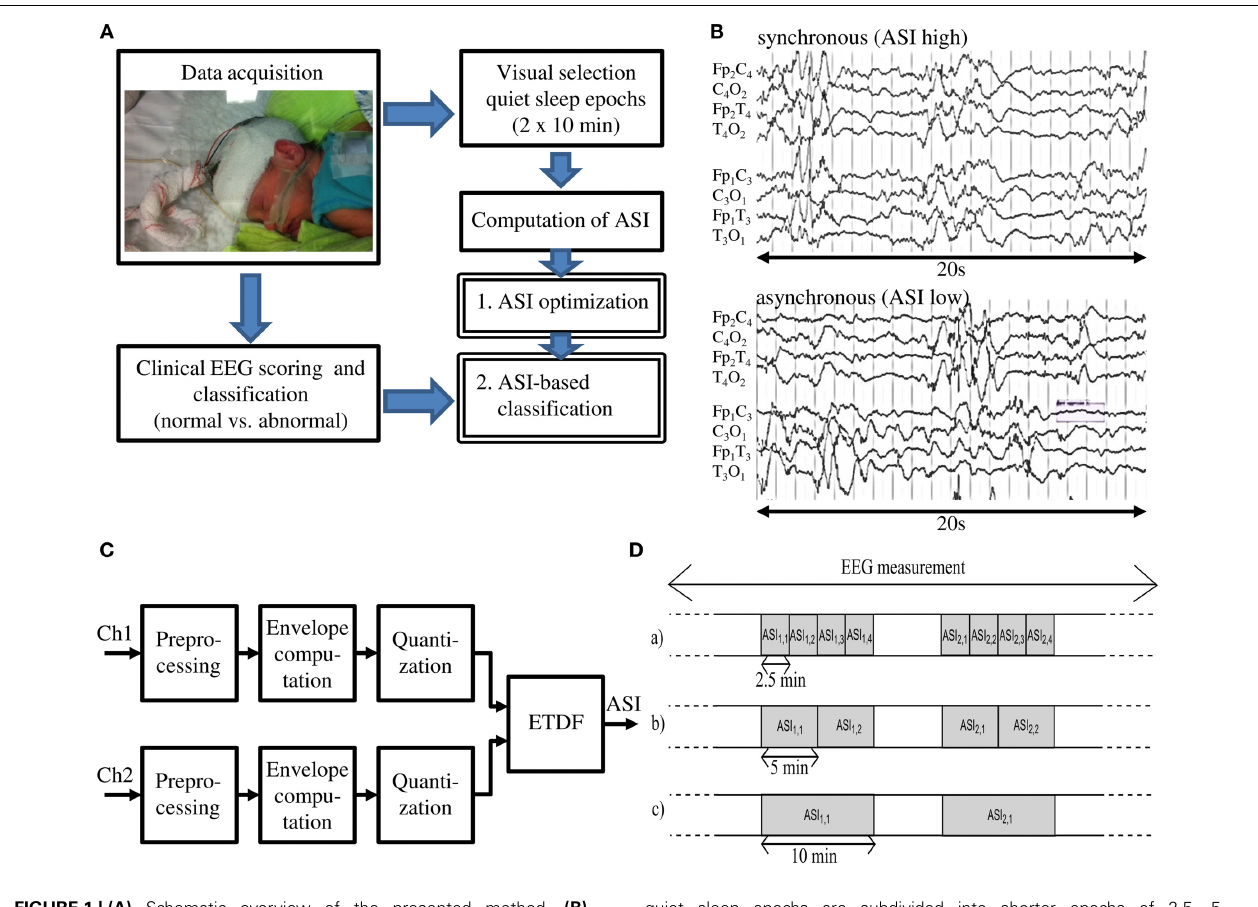
FIGURE 1 | (A) Schematic overview of the presented method. (B) EEG tracks with Normal and Abnormal synchrony. (C) Schematic view of the ASI algorithm (Räsänen et al., 2013). (D) Two 10-min